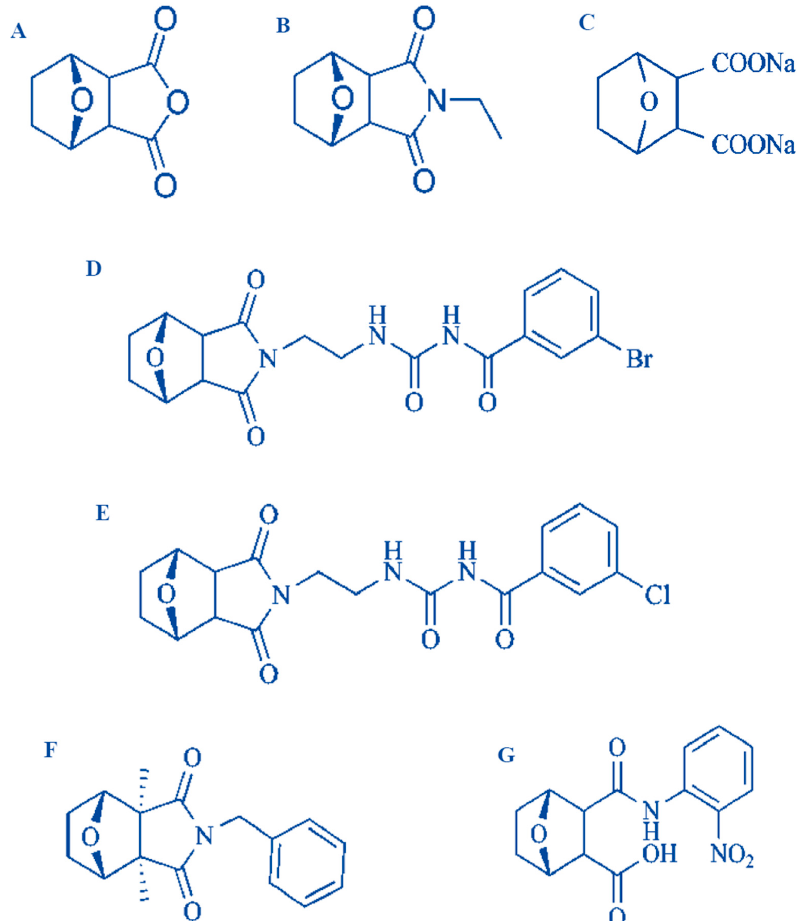
Figure 2. Structure of several derivatives of cantharidin ( A ) Norcantharidin, ( B ) norcantharimide, ( C ) Figure 2. Structureofseveralderivativesofcantharidin( A )Norcantharidin, ( B )norcantharimide, ( C